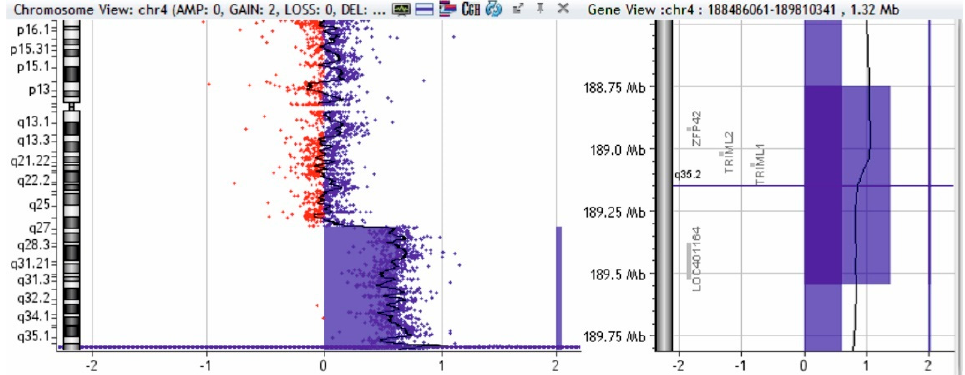
Figure 6. Array-CGH test of patient—quadruplication of 795 kb in the 4q35.2 region (shaded in blue). Red and blue dots represent the log2 ratio of fluorescence (Cy5/Cy3), calculated by analytical software; log2 ratio at 1 indicates a duplication of the DNA of the region (3 copies) in the test sample versus the control (in blue color), and a log2 ratio at -1 indicates a deletion of the DNA of that region in the test sample versus the control (red deviation).